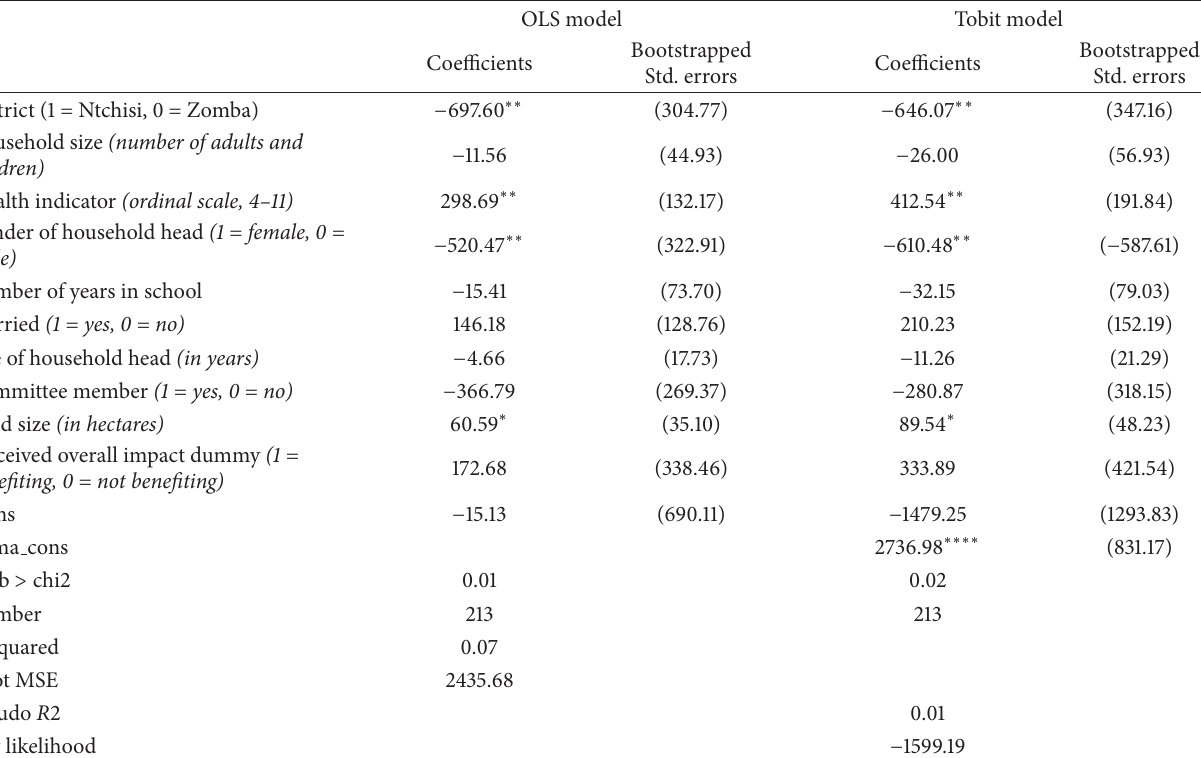
Table 6: Factors affecting how much households’ willingness to pay a membership fee to participate in comanagement programme in Zomba and Ntchisi districts (in Malawi Kwacha).